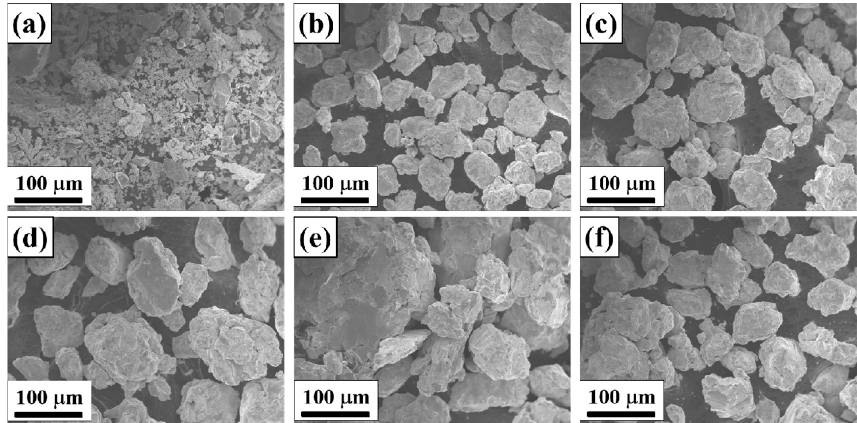
Figure 5. SEM photos of Ni 1.5 HEAP after different ball milling times: ( a ) 0 h, ( b ) 5 h, ( c ) 10 h, ( d ) 15 h, ( e ) 30 h, ( f ) 45 h.